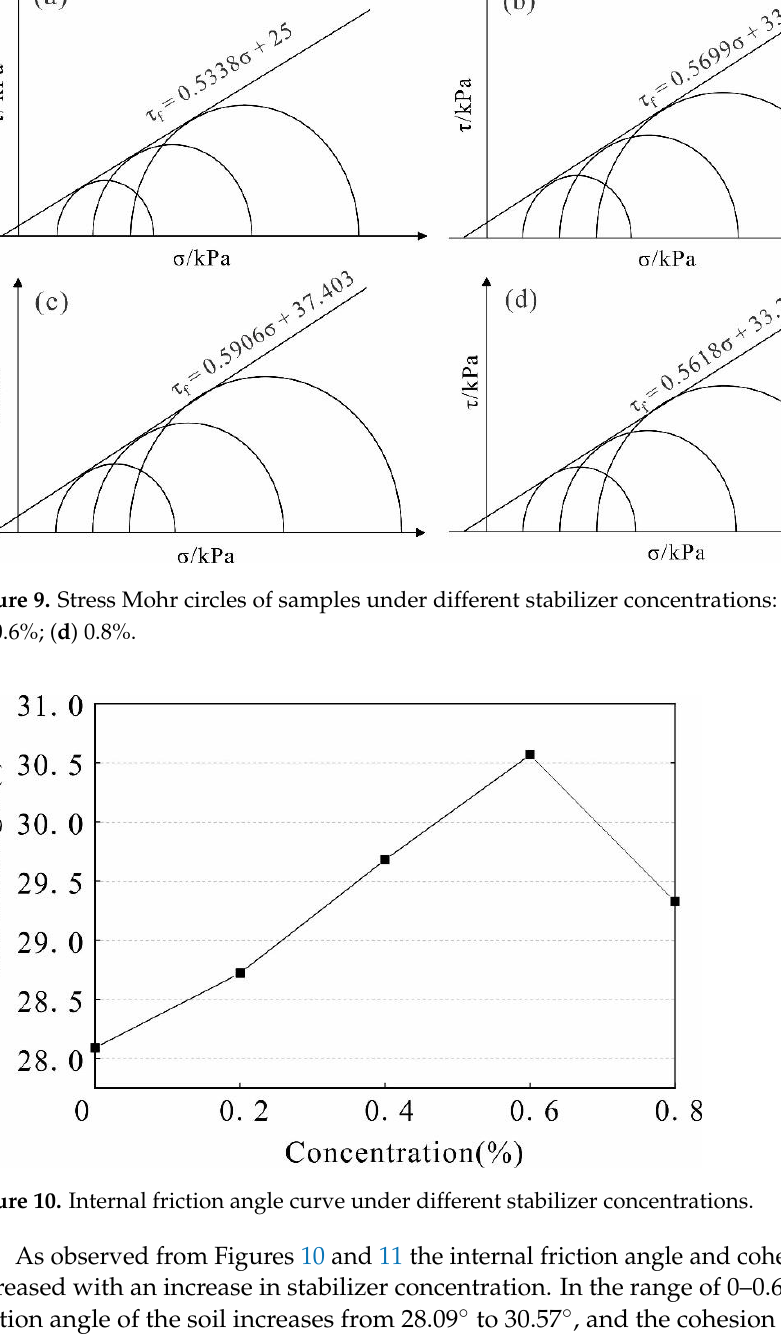
Figure 11. Cohesion curve under different stabilizer concentrations.